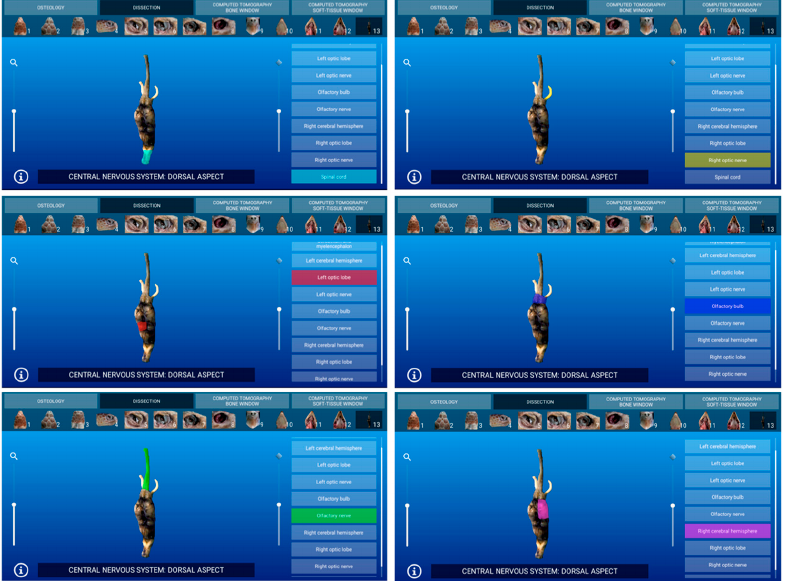
Figure 6. Atlas dissections section: an interactive image of the central nervous system is shown in dorsal